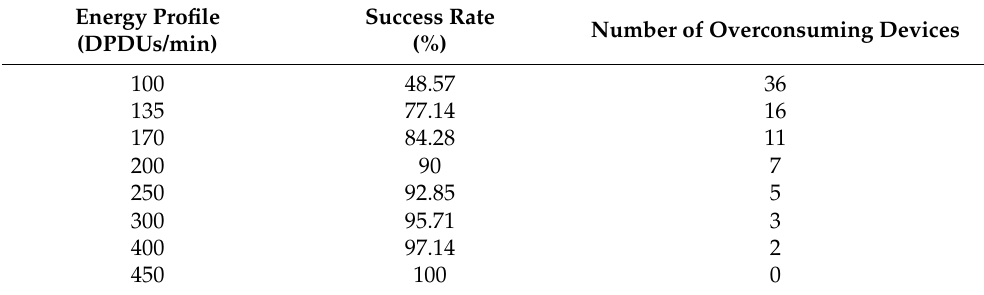
Table 1. The PEAR success rate with respect to the energy profile.